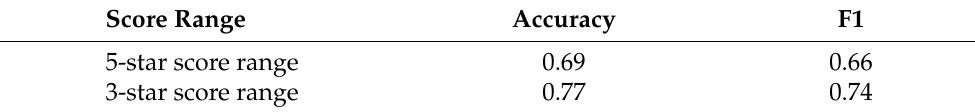
Table 10. Summary of score assigning results.